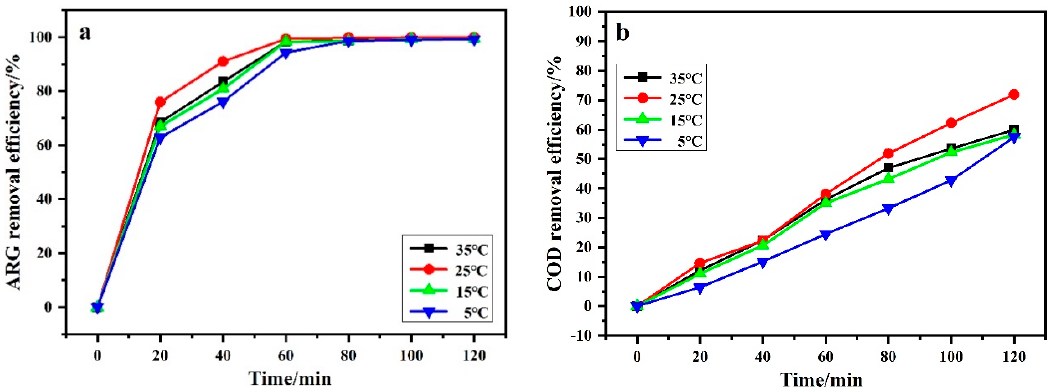
Figure 8. Effect of temperature on ARG removal efficiency ( a ) and COD removal efficiency ( b ). Other Figure 8. E ff ect of temperature on ARG removal e ffi ciency ( a ) and COD removal e ffi ciency ( b ). Other operating conditions: Current density of 50 mA/cm 2 and ARG concentration of 100 ppm . operating conditions: Current density of 50 mA / cm 2 and ARG concentration of 100 ppm.